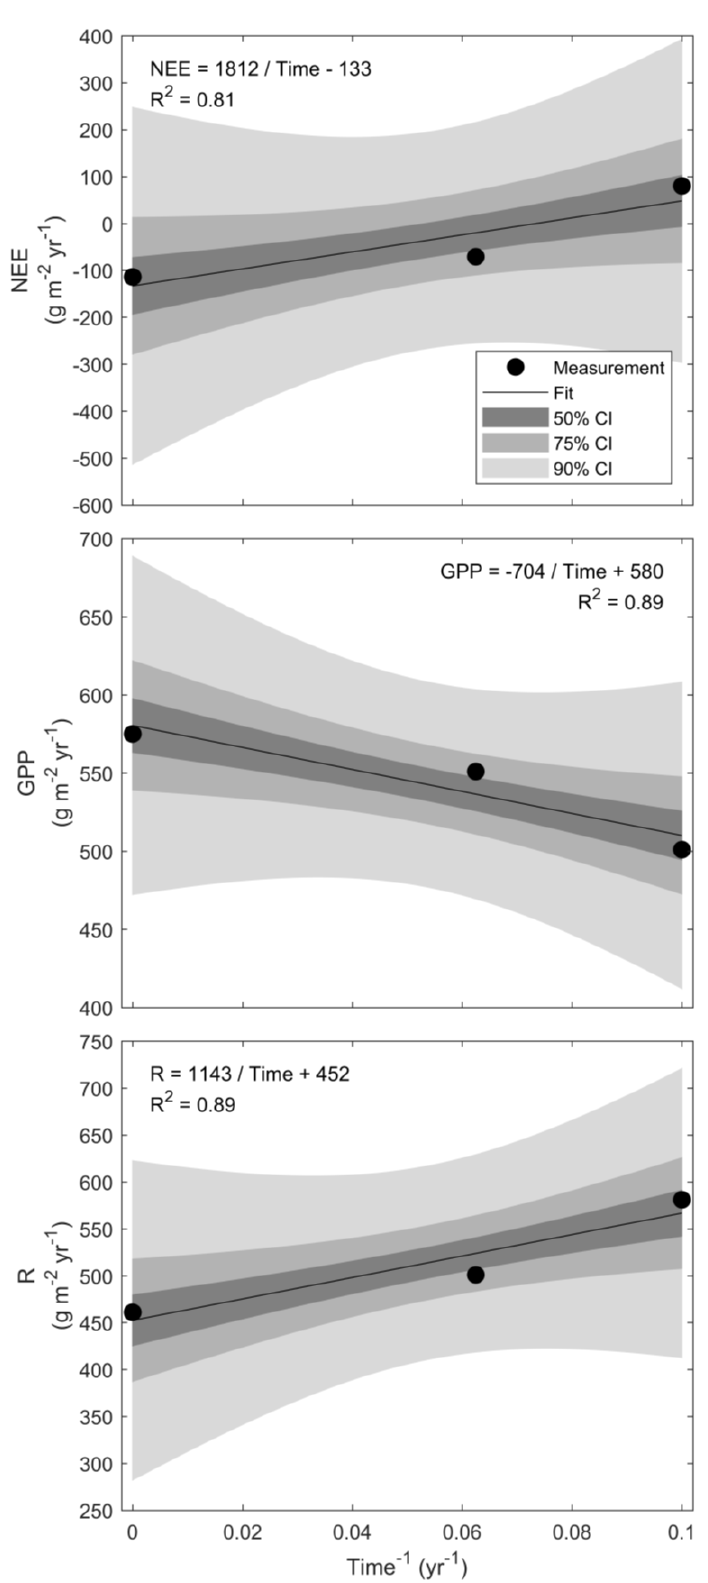
Figure 5. Black points indicate annual NEE (panel a), GPP (panel b) and R (panel c) of the three sites plotted against the reciprocal of their time since restoration (Time -1 ). Fluxes expressed as CO Time -1 is: Cross Lochs (∞ -1 = 0), Talaheel (16 -1 = 0.063) and Lonielist (10 -1 = 0.1). The line of best fit (black line) for the dependent variables: NEE (panel a), GPP (panel b) and R (panel c). Shaded areas correspond to the 90 %, 75 % and 50 % confidence intervals (CI) for the line of best